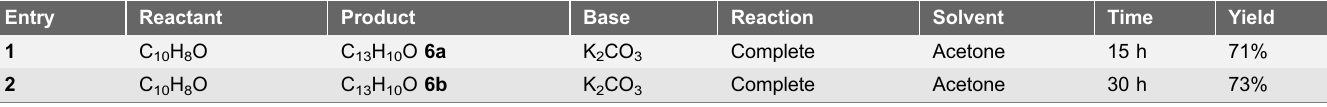
Table 3. Optimization of reaction conditions for compounds 6a–b